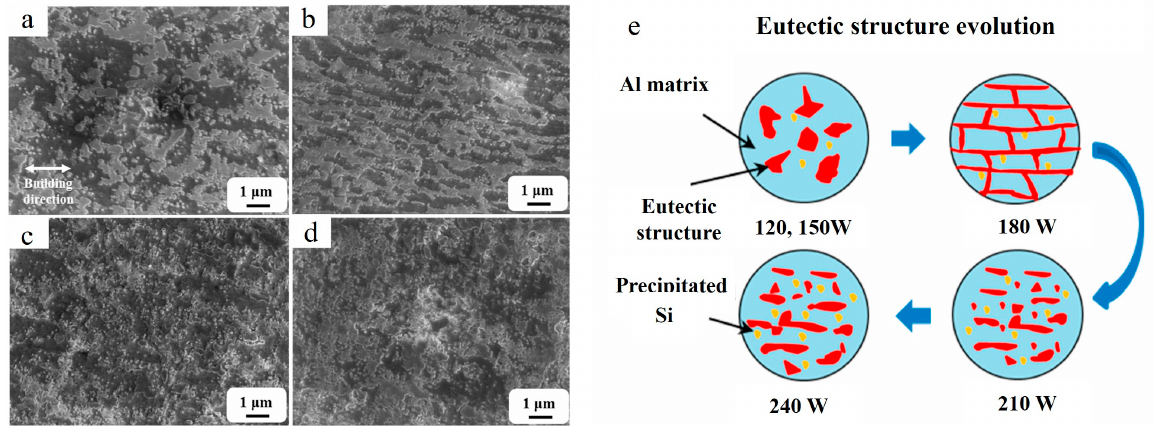
Figure 16. High-magnification SEM micrographs of as-built AlSi10Mg/SiC composites fabricated at different laser powers of 120 W ( a ), 180 W ( b ), 210 W ( c ), 240 W ( d ) and graphical illustration for development of eutectic structure ( e ) (reproduced with permission from [95]).